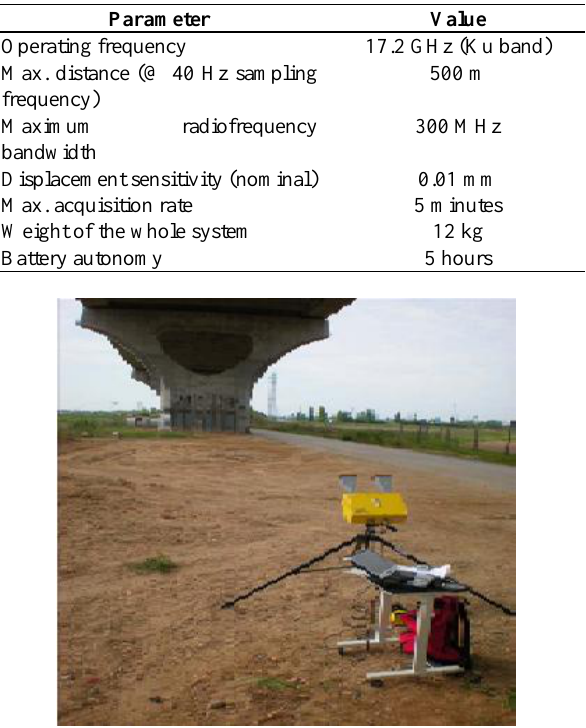
Figure 2. An IBIS-S System for bridge